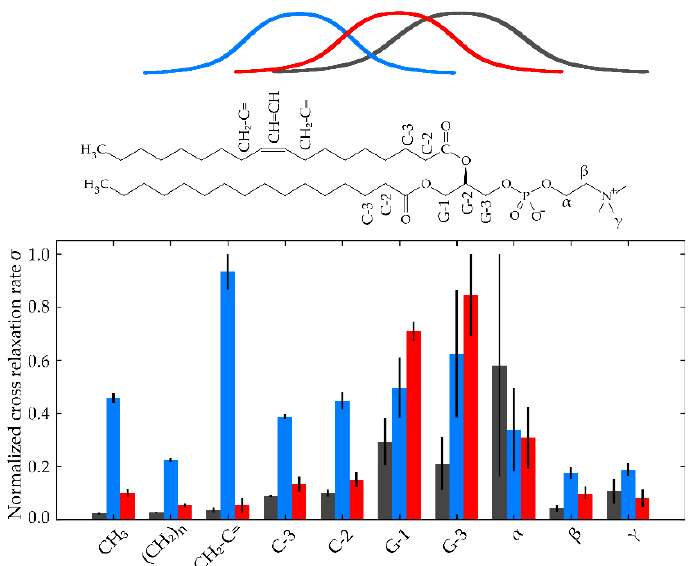
Figure 2. Normalized cross relaxation rates of the protons (I1-red, I6-blue, I7-green, see also Figure 1) of idelalisib with the proton groups of the POPC membrane. The data show that the aromatic ring of the molecule points into the hydrocarbon membrane, while both the naphtalene and the indane-like substructures are oriented towards the aqueous phase. On average, idelalisib is localized in the glycerol region of the membrane, however, it remains mobile throughout the bilayer.